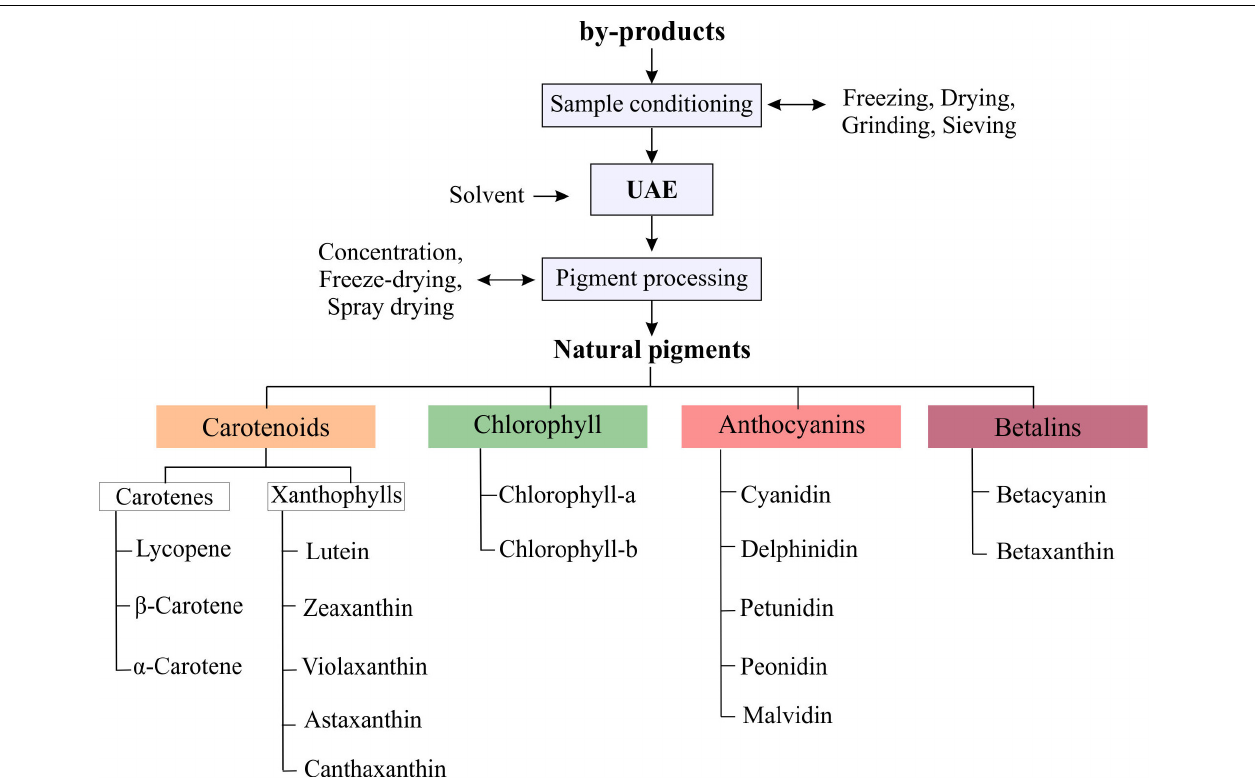
FIGURE 5 | Types of pigments that were obtained from by-products by applying the UAE